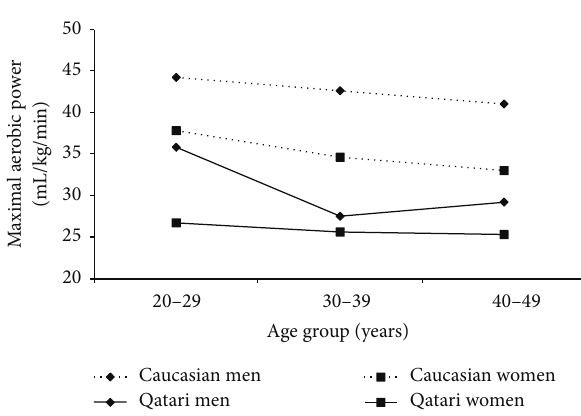
Figure 2: Aerobic fitness in Qatari men and women in the current study, compared to the reported 50th percentile of aerobic fitness in a Caucasian population